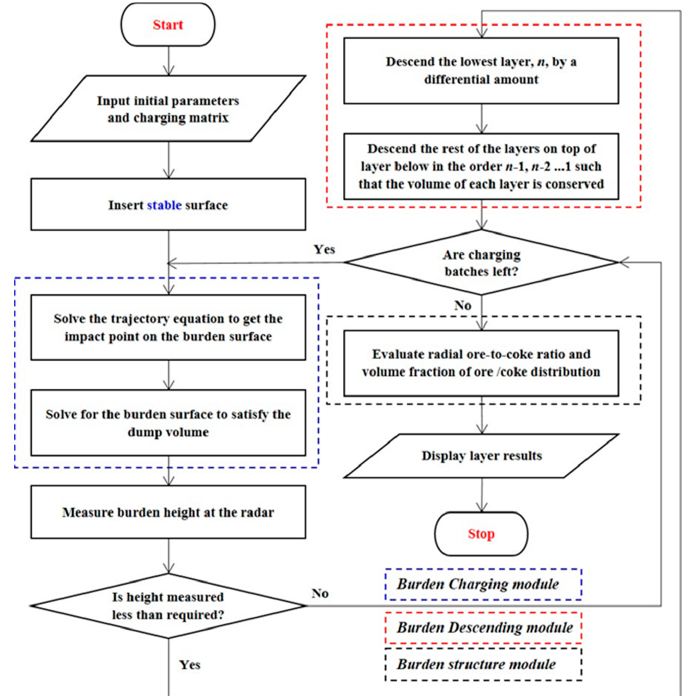
Figure 3. Flowchart of the mathematical model.